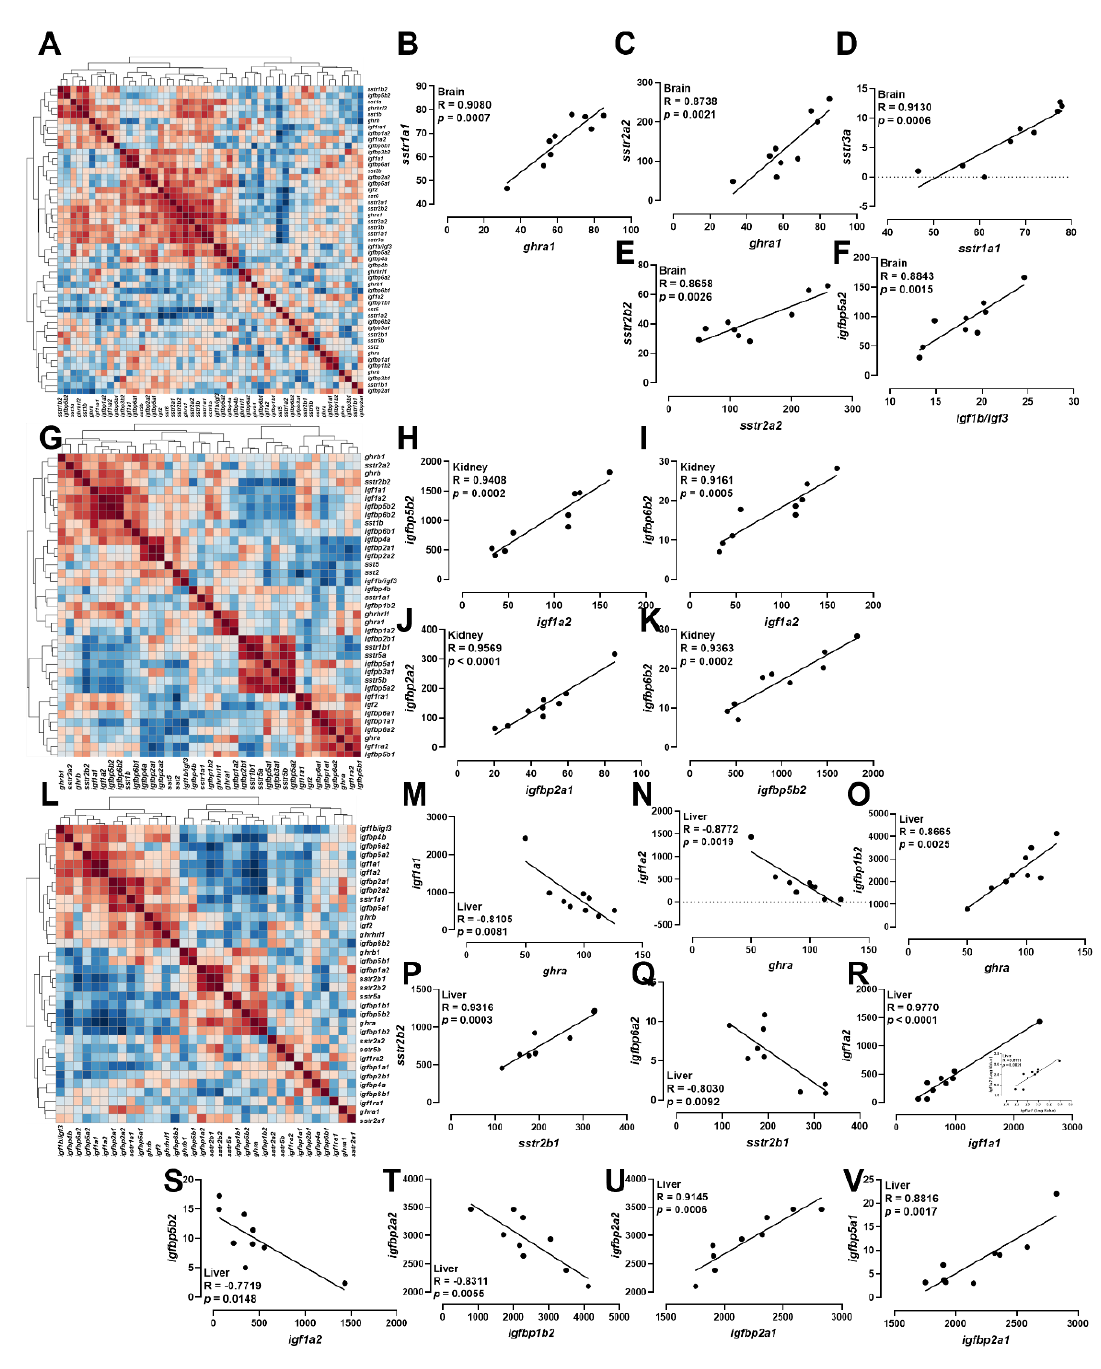
Figure 6. Correlation analysis of ghrh-sst-gh-igf axis in brain, kidney, and liver. ( A – F ) Heatmap of correlation of ghrh-sst-gh-igf axis in brain ( A ) and the Pearson correlation coefficient of two genes in brain ( B – F ). ( G – K ) Heatmap of correlation of ghrh-sst-gh-igf axis in kidney ( G ) and the Pearson correlation coefficient of two genes in kidney ( H – K ). ( L – V ) Heatmap of correlation of ghrh-sst-gh-igf axis in liver ( L ) and the Pearson correlation coefficient of two genes in liver ( M – V